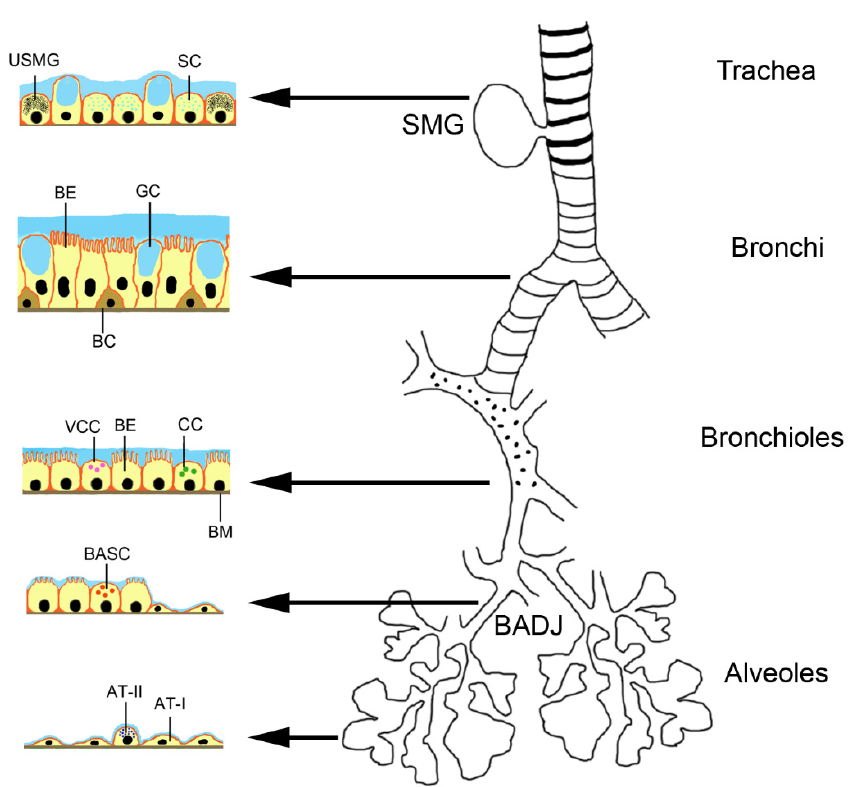
Figure 1. Location of stem cells and progenitor cells in the murine respiratory tract. Abbreviations: AT-I, alveolar epithelial cell type 1; AT-II, alveolar epithelial cell type 2; BADJ, broncholveolar duct junction; BASC, bronchoalveolar stem cells; BC, basal cell; BE, bronchial epithelial cell; BM, basal membrane; CC, Club cell; GC, goblet cell; SC, serous cell; SMG, seromucosal gland; USMG, undefined seromucosal gland duct cell; VCC, variant club cell.